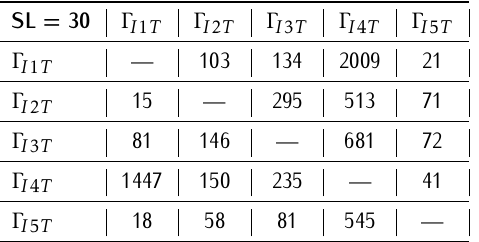
Table 2. Number of light intensity segments and unique light signatures with various SL for trajectory segment Deva to Timis oara , Similarities between measurements are captured in a trajectory specific light signature data-set Φ as described in equation 4.